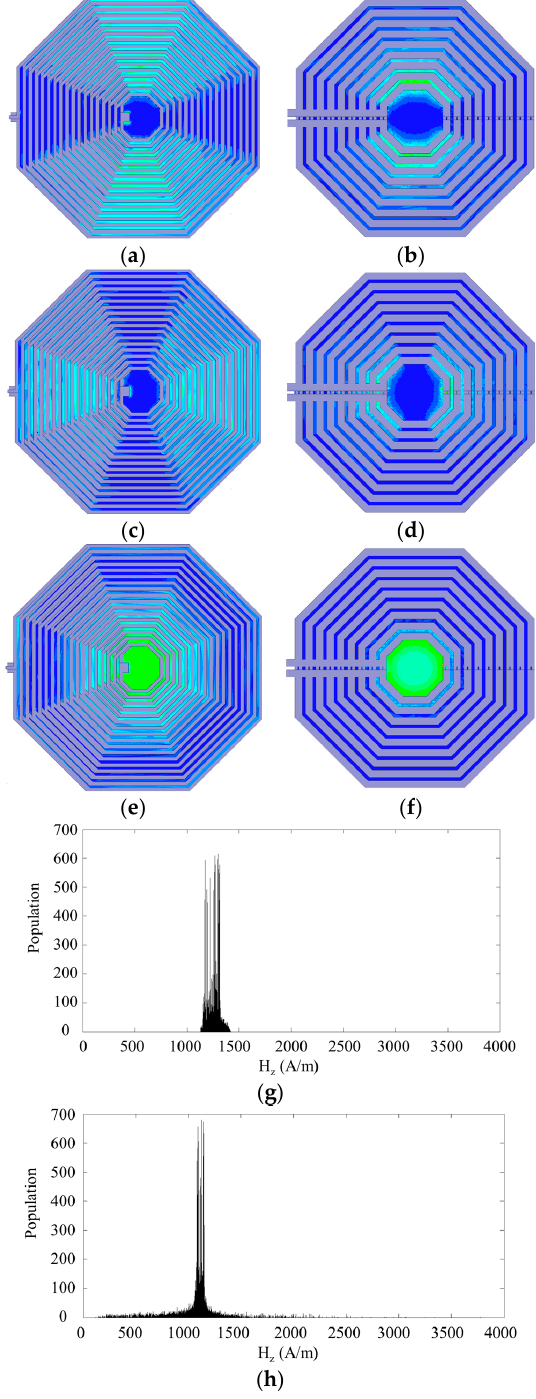
Figure 6. Magnetic field ( B 1 ) simulation results: ( a , c , e ) B 1 x , B 1 y , B 1 z , generated by SSC, respectively; ( b , d ) and ( f ) B 1 x , B 1 y , and B 1 z , generated by DSC respectively; uniformity of magnetic field in the ( g ) DSC and ( h ) SSC models. Population defines as the number of pixels in the center of micro-coils with the same magnetic field strength (Hz).